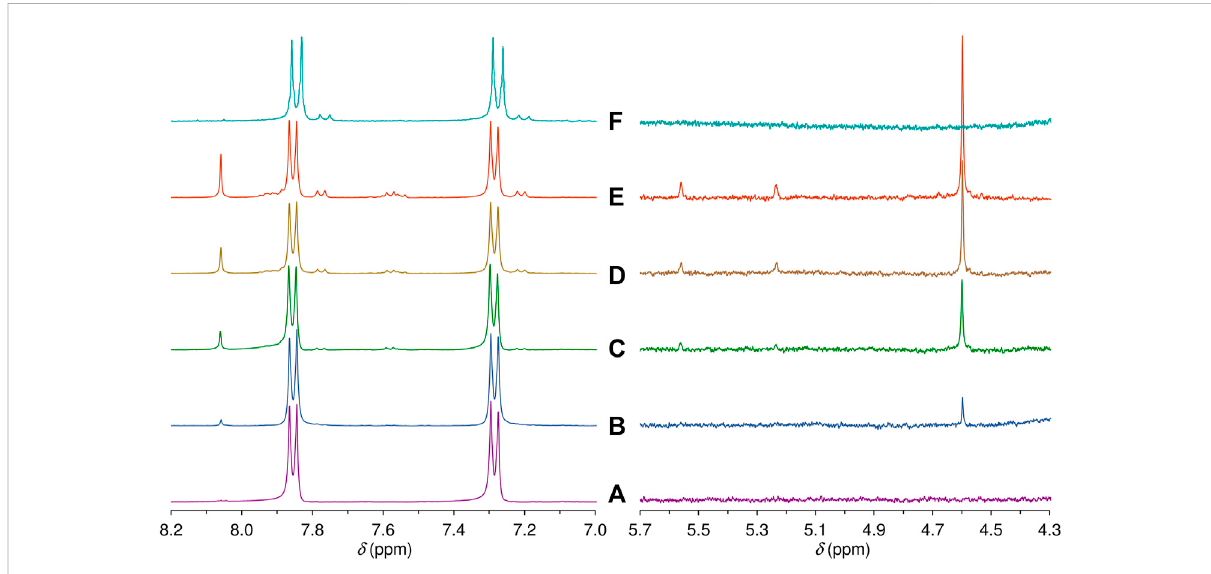
FIGURE 8 Aromaticandmid- fi eldregionsofthe 1 HNMRspectraobtainedafterirradiatingasolutionoftheketodiacid 3 inDMSO-d 6 for (A) 0 h, (B) 3 h, (C) 5 h, (D) 8 h,and (E) 12 h.For comparison, (F) shows thesameregionsof the 1 HNMRspectrumobtained inaDMSO-d 6 solutionof theirradiated solid i 3 (see main text for details).